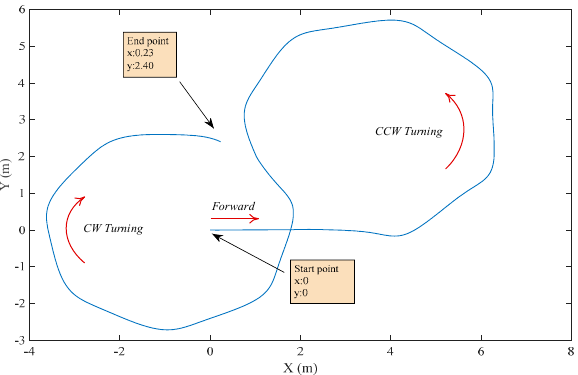
Figure 11. Free-swimming motion of the robotic fish. It is noted that there are three swimming modes: Forward, Counter Clock Wise (CCW) and Clock Wise (CW) turning.